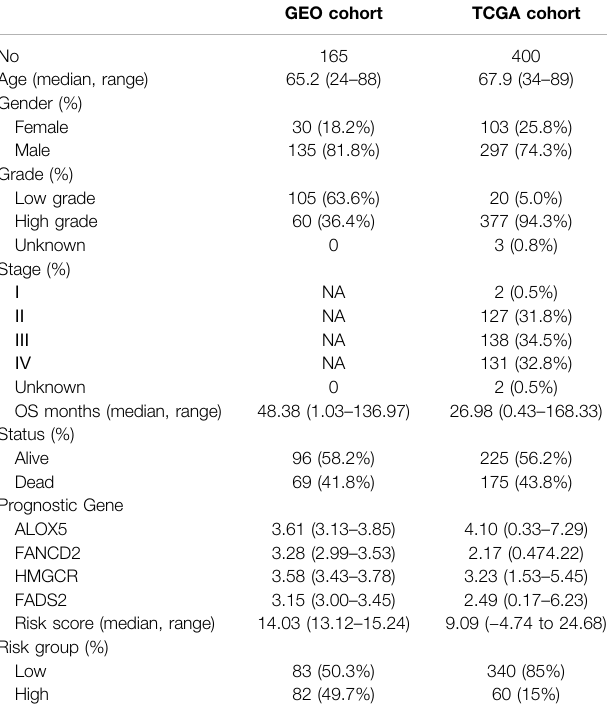
TABLE 1 | Characteristics of BC patients used in this